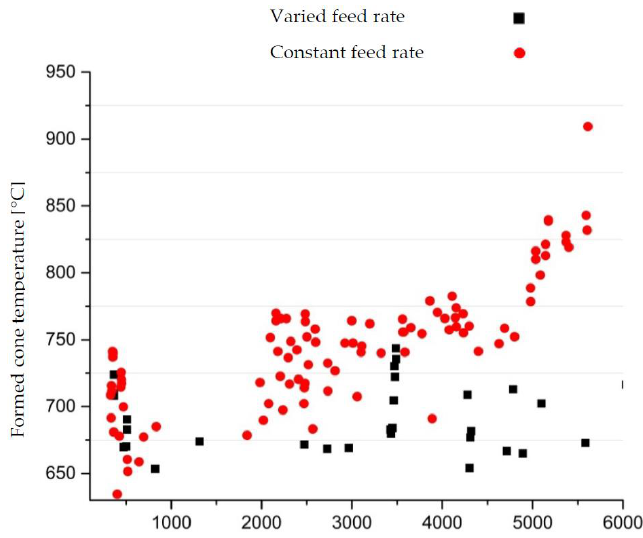
Figure 9. The temperature distribution on a 62° wall cone during forming with a constant and varied feed rates from the beginning until the end of the operation.